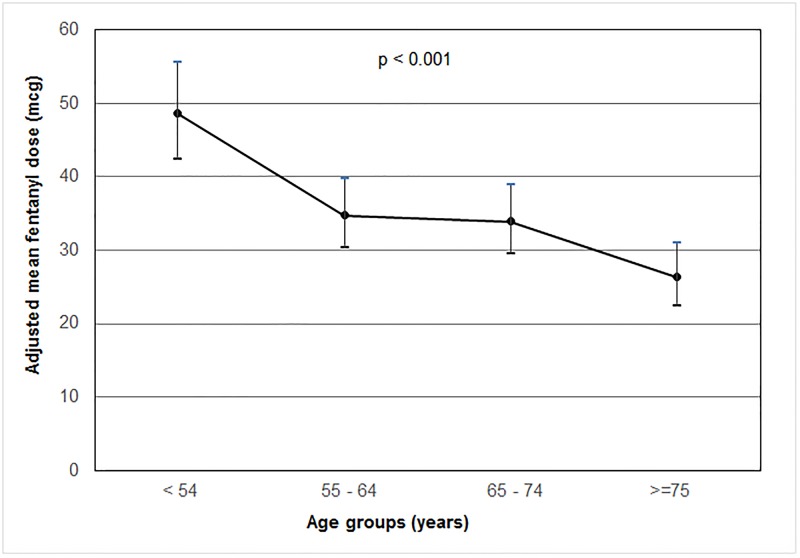
Adjusted mean total dose of fentanyl according to age groups.